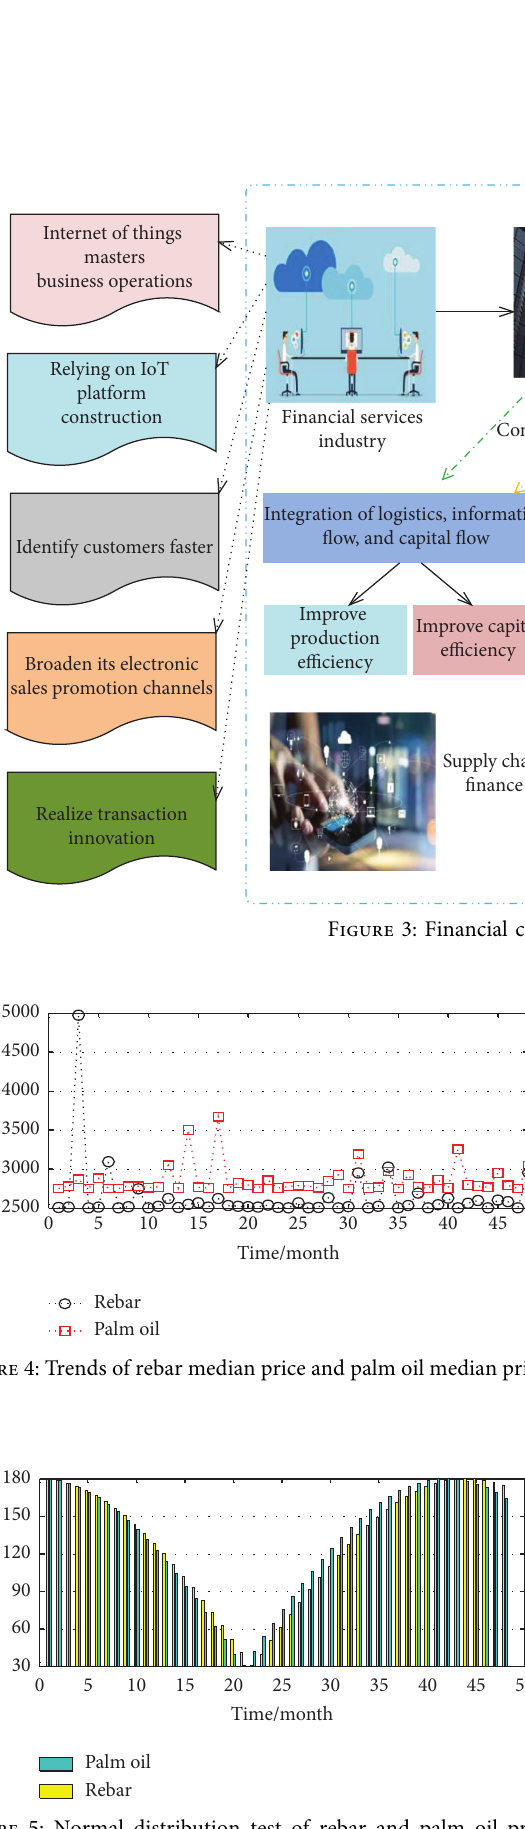
Figure 5: Normal distribution test of rebar and palm oil price change series.